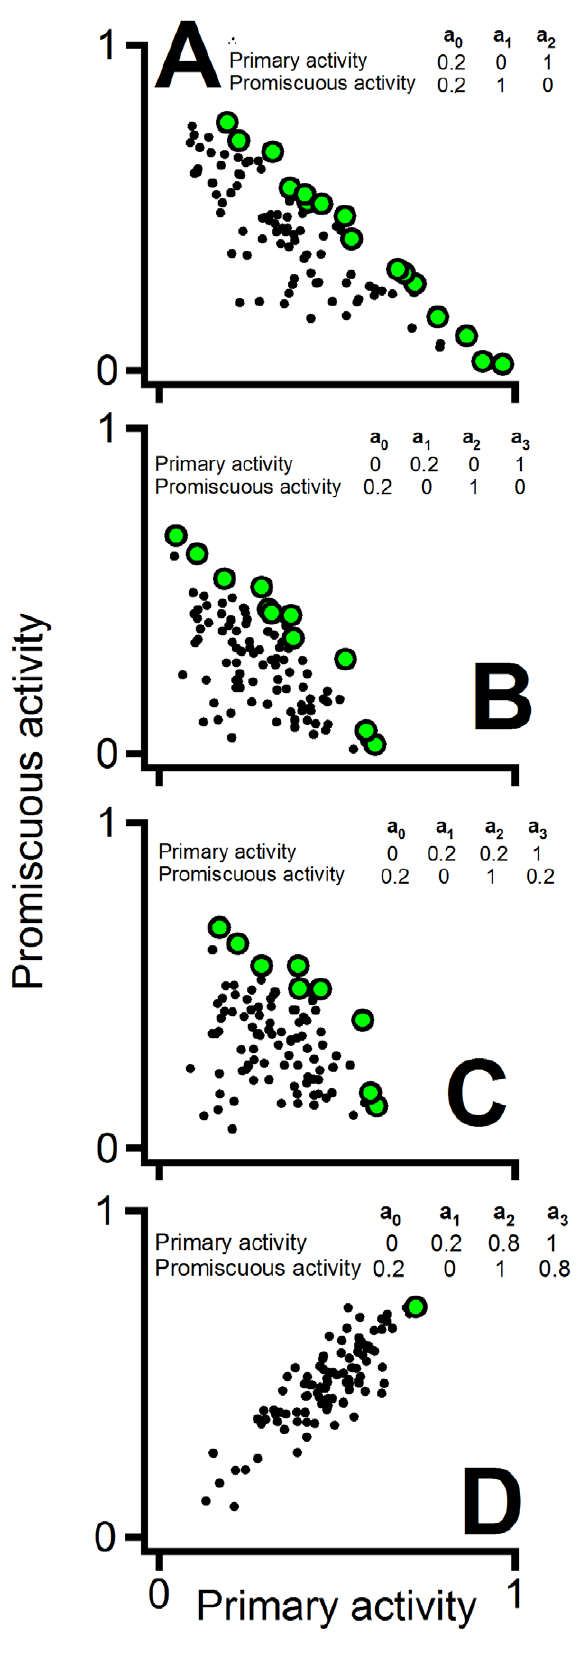
Figure 9. Stochastic simulations of primary/promiscuous activities based on different conformational diversity models. (A) Simulation based on a 3-conformation model identical to that used in the simulation of Figure 8E, except that a low (but different from zero) level of primary and promiscuous activities for the suboptimal conformation ( a 0 ) is assumed. Here, as well as in the other panels, the Pareto set is shown with green circles. (B) Simulation based on a 4- conformation model with two suboptimal conformations. (C) Same as in (B), except that each one of the optimal conformations ( a 2 and a 3 ) has a low level of the alternative activity. (D) Same as in (C), but assuming that the optimal conformations show high level of both activities. The models used in (A), (B) and (C) include the existence of trade-offs between the optimal conformations and yield roughly linear Pareto sets with a significant number of data points below the Pareto set due to the presence of suboptimal conformations. This is actually the experimental pattern we have found for the catalysis-of-oxidative- folding/reductase activities (Figure 8A). The model used in (D) does not include trade-offs between the optimal conformations (i.e., a 2 and a 3 efficiently catalyze both, the primary and the promiscuous processes) and the pattern is completely different: a significant correlation between the two activities and a very small Pareto set are